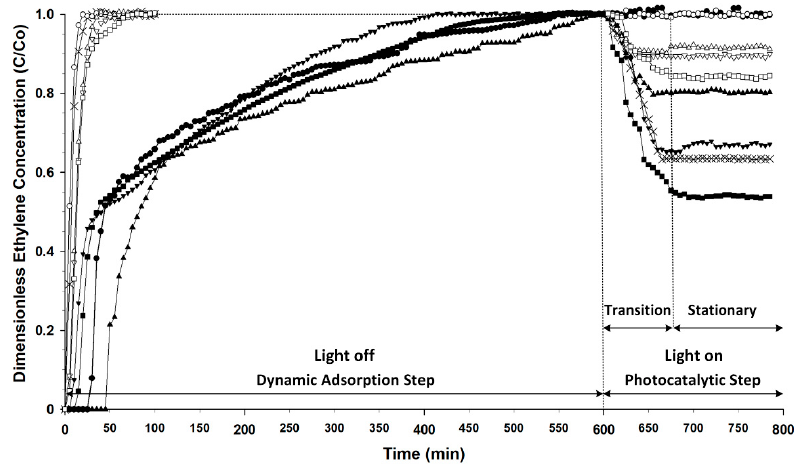
Figure 5. Ethylene adsorption and photocatalytic degradation using parent zeolite support. Pre- pared single and double metal oxide catalysts supported on modified natural zeolite, raw fumed silica, prepared single and double metal oxide catalysts supported on fumed silica, and TiO 2 mixed with raw fumed silica: • ZNAT, ▲ ZH_Cu, ▼ ZH_Zn, ■ ZH_Zn/Cu, ○ FS, △ FS_Cu, ▽ FS_Zn, □ FS_Zn/Cu, X FS_TiO 2 .